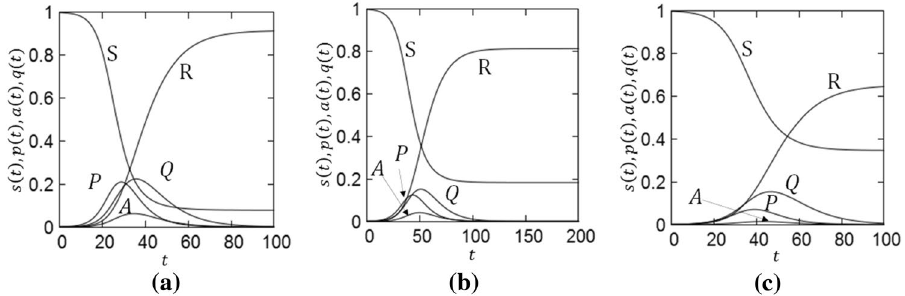
Figure 2. Time evolution of population in each compartment of the SPAQR model for COVID-19. ( a ) δ = 0.0, β = 0.4 , ( b ) δ = 0.0, β = 0.3 , ( c ) δ = 0.1, β = 0.4 .